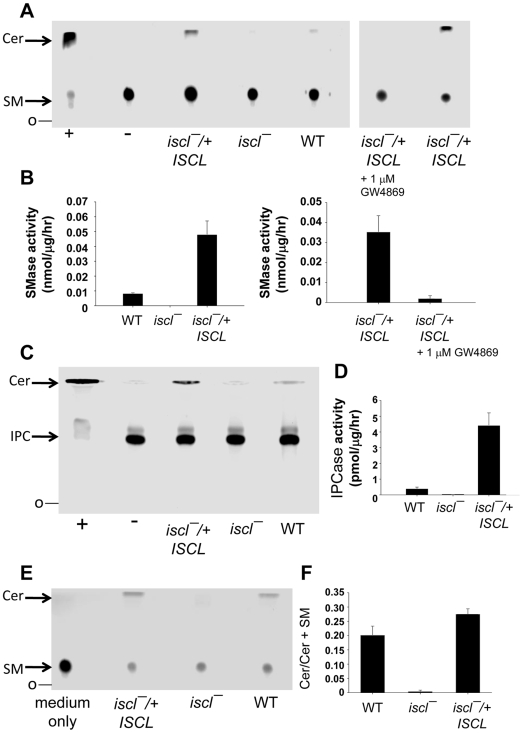

ISCL is required for the hydrolysis of sphingomyelin and IPC.(A)–(B) In vitro neutral SMase assay. Whole cell lysates from log phase promastigotes (∼40 µg of protein each) were incubated with TX100-based micelles containing NBD-labeled sphingomyelin as described in 
Materials and Methods
. Neutral SMase inhibitor GW4869 was provided as indicated (1 µM final concentration). Lipids were extracted and separated by TLC. Plates were scanned using a Storm 860 phosphoimager and the activity of SMase was normalized to nmol/µg/hour. Positive control (+): 0.1 unit of B. cereus SMase; negative control (−): boiled WT lysate. (C)–(D) Degradation of sphingomyelin by promastigotes in vivo. Parasites were cultured in the presence of NBD-labeled sphingomyelin for 48 hours and lipids were extracted and separated by TLC (“medium only” means NBD-labeled sphingomyelin was incubated in the absence of parasites for 48 hours). Ratio of ceramide/ceramide + sphingomyelin (SM) was determined using an Image Analysis Software (ImageQuant TL 7.0) and used as an indicator of sphingomyelin hydrolysis. (E)–(F) ISCL is required for the degradation of IPC. Whole cell lysates from log phase promastigotes (∼40 µg of protein each) were incubated with TX100-based micelles containing NBD-labeled IPC as described in 
Materials and Methods
. Lipids were extracted and separated by TLC. Plates were scanned using a Storm 860 phosphoimager and the activity of IPCase was normalized to pmol/µg/hour. Experiments were performed in duplicates and error bars represent standard deviations. O: origin of TLC.